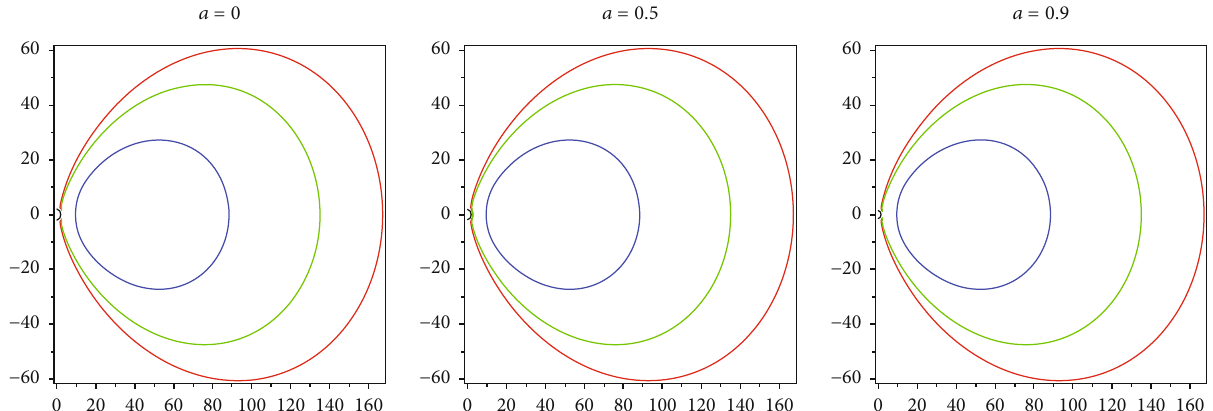
Figure 6: Contour plots depicting lines of constant ξ -values (31) for Example 2, using three di ff erent values of the Kerr parameter a . Red lines correspond to ξ = 0 : 1 , green to ξ = 1 , and blue to ξ = 10 . Along these lines the electromagnetic fi eld is, respectively, of the pure magnetic type, pure null type, and pure electric type; see (30). Green lines correspond to the light